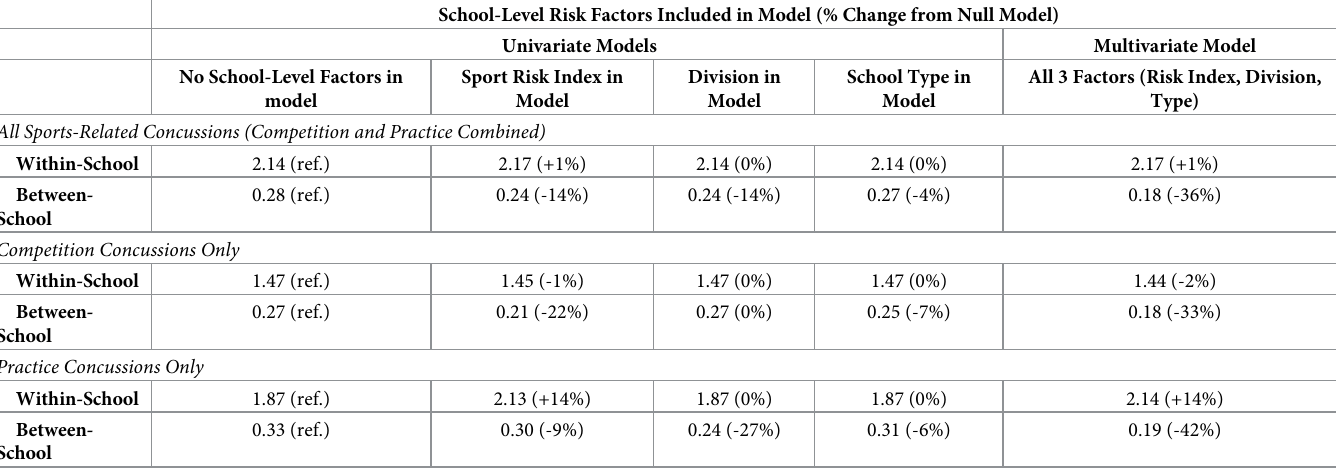
Table 2. Estimated variance 1 in sports-related concussion, CARE CSC, 2014/15 to 2018/19 academic